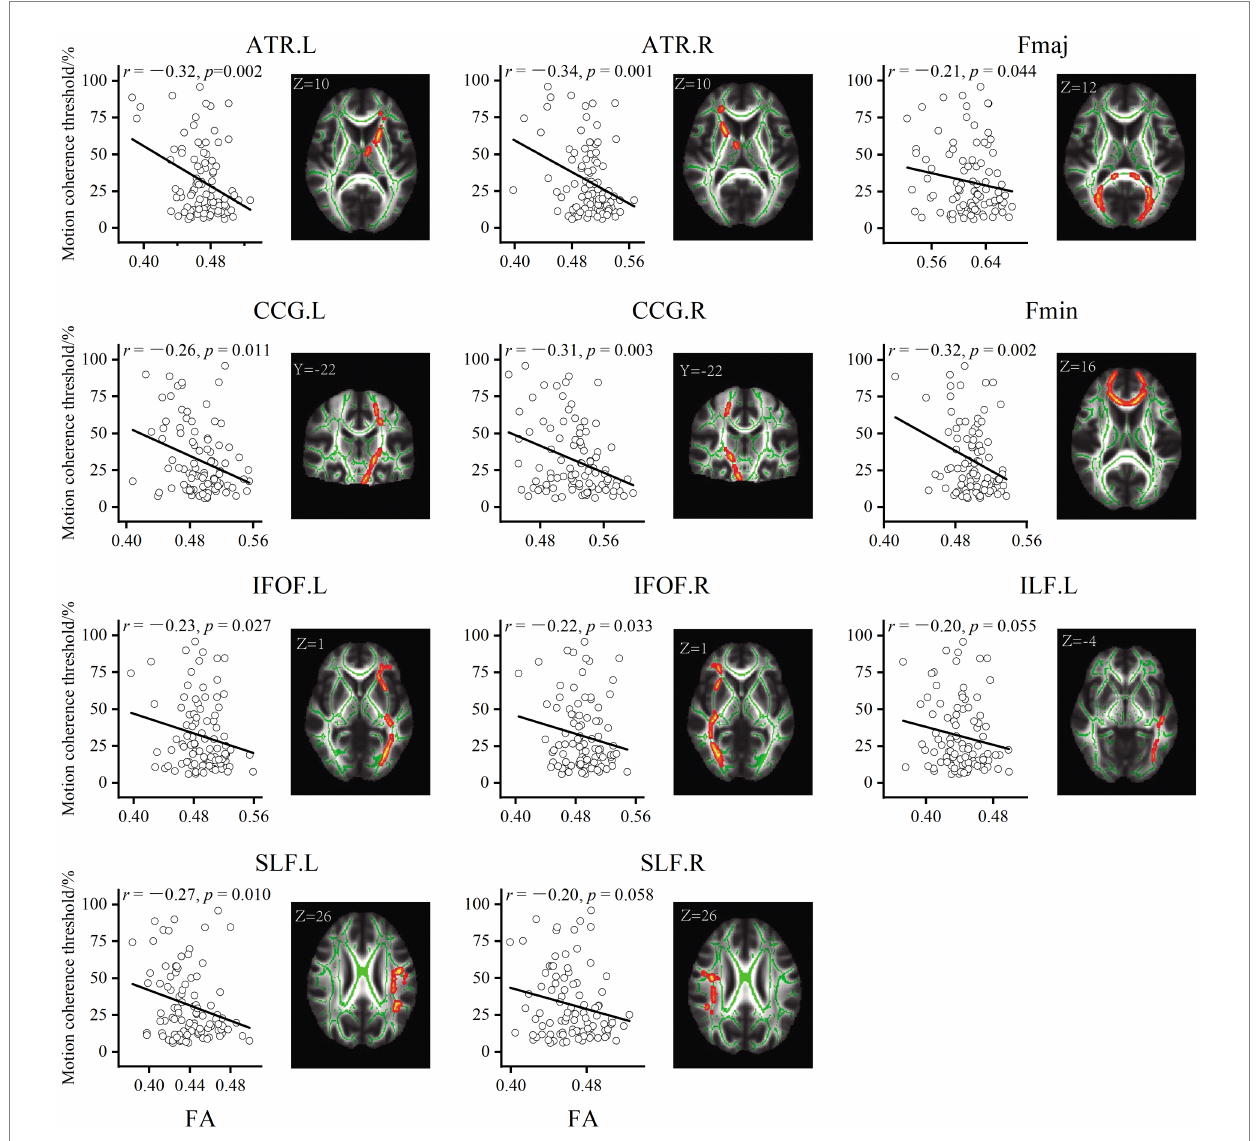
FIGURE 3 Results of the partial correlation analyses between FA and MCT in older adults. All correlations were significant at p < 0.05 (threshold-free cluster enhancement corrected). Decreased fractional anisotropy in the bilateral SLF, IFOF, ATR, CCG, and left ILF was associated with worse GMP.